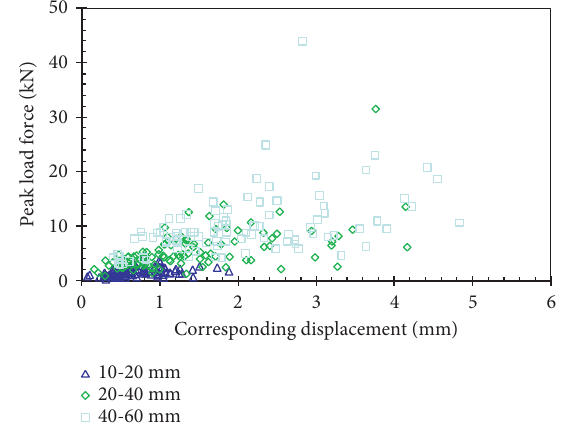
Figure 9: Te valuation of the peak stress and